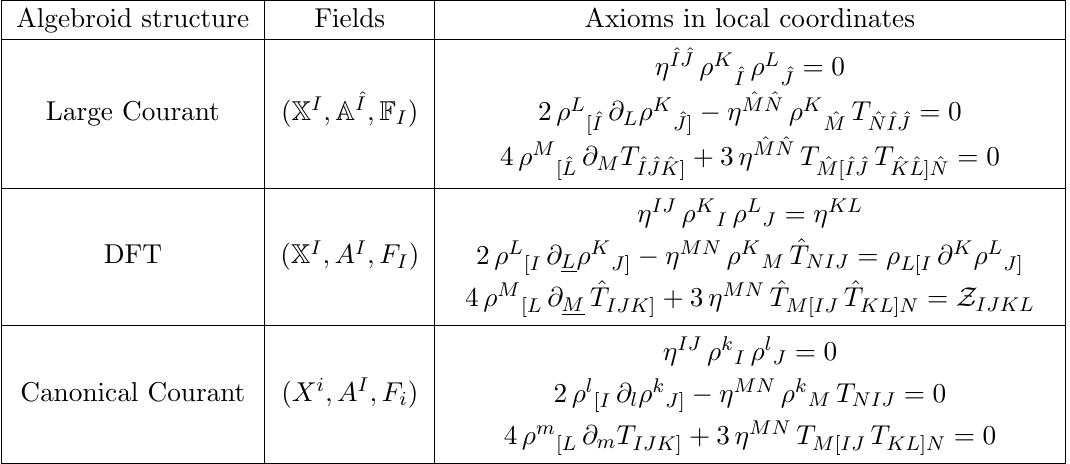
The (cid:12)elds and local coordinate expressions for the axioms of the three di(cid:11)erent geometric structures encountered. With reference to the classical master equation, the three sub-rows in the last column of each row are the 0-form coe(cid:14)cients in front of the 4-forms F F F A ^ I A ^ J =F I A J =F I A J for the second sub-row, K L =F K F L =F k F l for the (cid:12)rst sub-row, K K A k A and A ^ I A ^ J A ^ K A ^ L =A I A J A K A L =A I A J A K A L for the third sub-row, respectively. Indices run